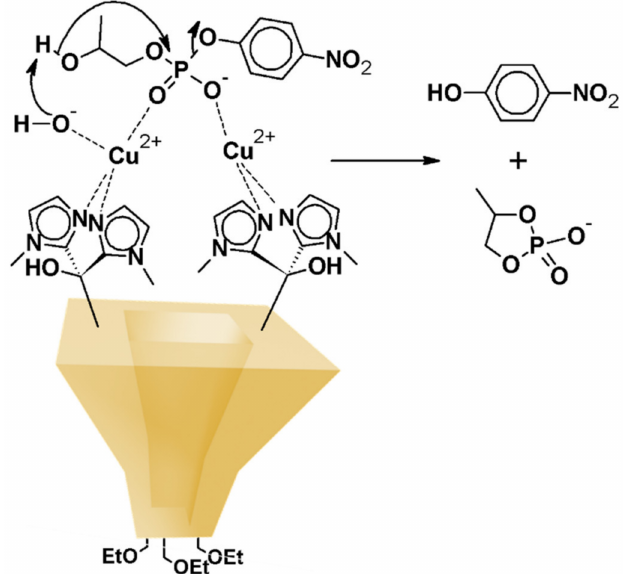
Figure 10. The cleavage of 2-hydroxypropyl- p -nitrophenylphosphate by a C[4]–Cu(II)